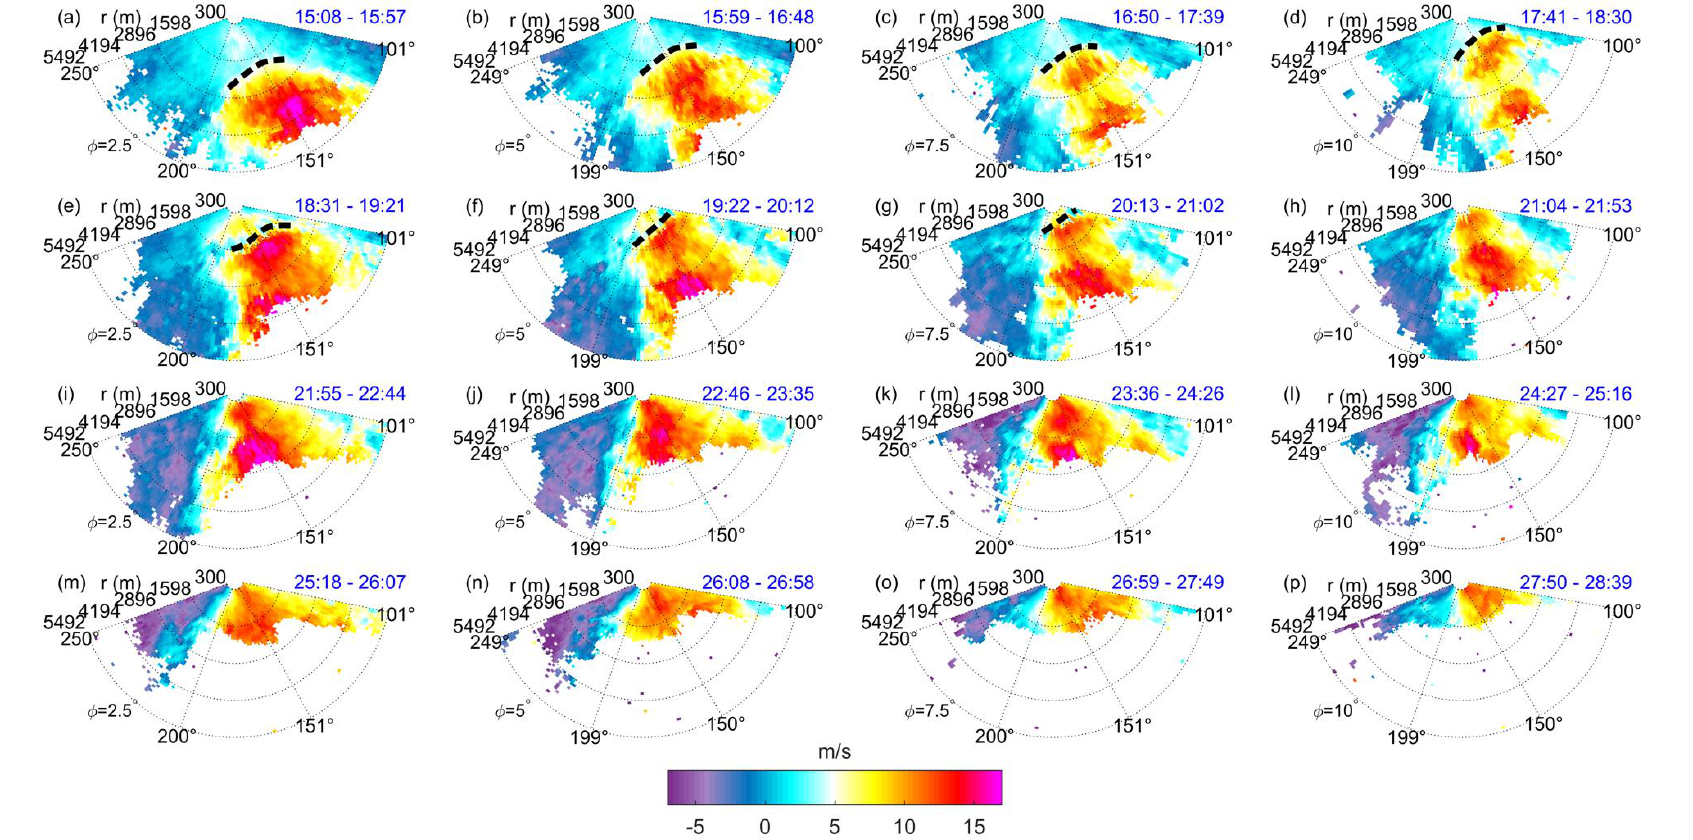
Figure 13. Doppler velocity measured by the WindCube Scanning Lidar 400S lidar located in the Port of Genoa. The beam elevation ( 𝜑 ) and the scanning time interval in MM:SS (blue text; the hour in all plots is 09:00 UTC) provided in each figure. The black dashed line in ( a )–( g ) shows the leading edge of the maximum velocity region. ( h )–( p ) panels show the evolution of the thunderstorm outflow from 21:04 UTC to 28:39 UTC.